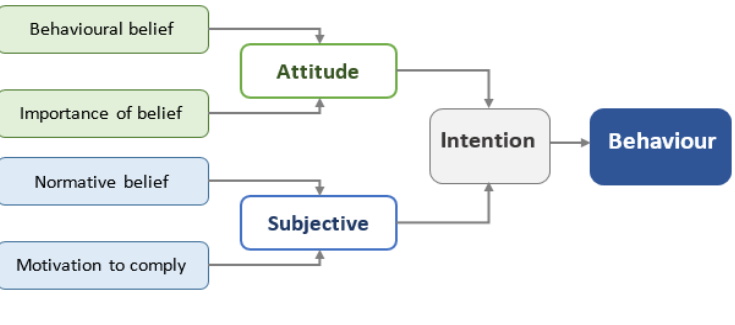
Figure 1: Theory of reasoned action; Source: Marandu et al.